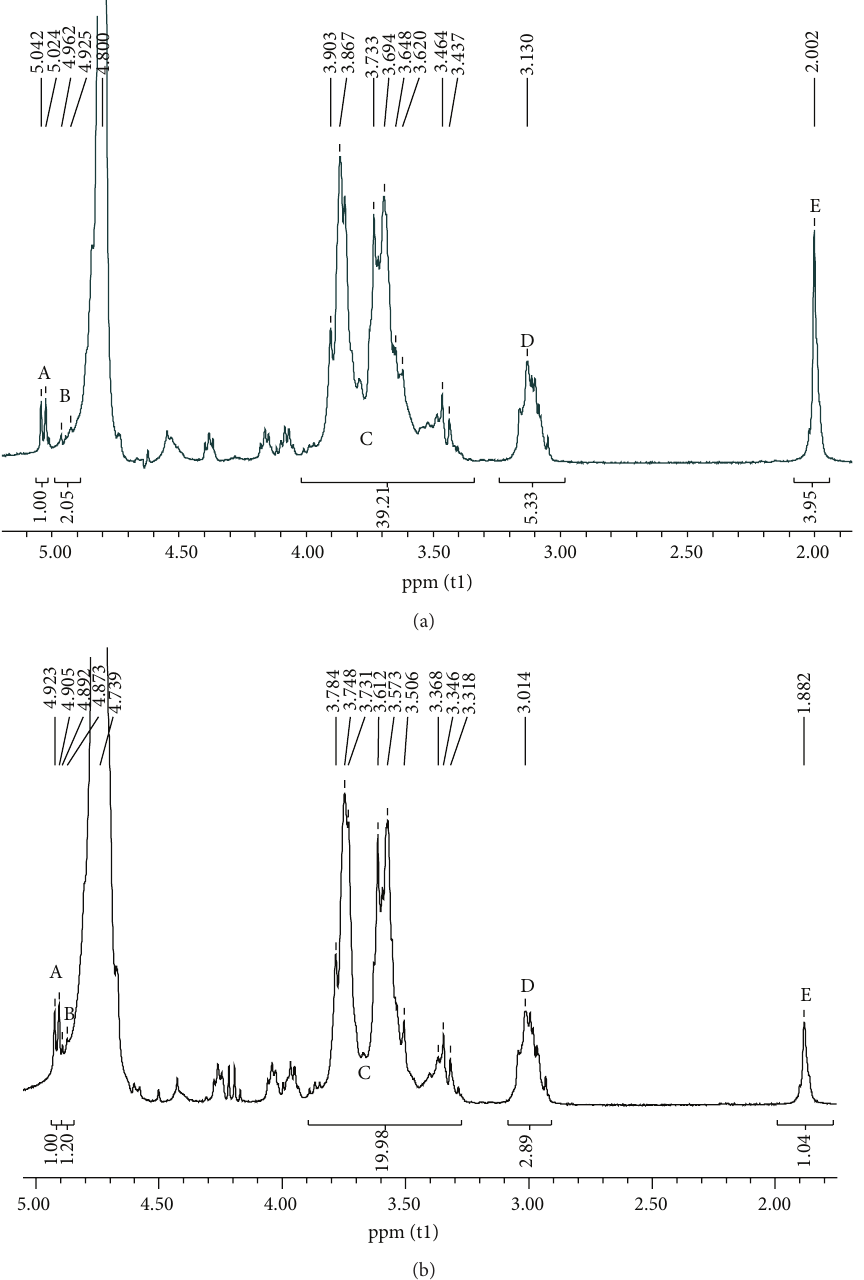
Figure 4: : 1 H NMR spectra of control chitosan sample A (a) and chitosan sample C (b), thermally treated at 100 ∘ C for 10h. 3 (0.33 mol dm −3 of acetic acid and 0.3 mol dm −3 of sodium chloride) as described by Roberts [8]. From the linear regres- sions of control chitosan (A) using solvents (1), (2), and (3) were calculated intrinsic viscosities and Mv values using the −1 , Mark-Houwink-Kuhn-Sakurada equation, 1,254,259 g mol 121,048 g mol −1 , and 193,400 g mol −1 , respectively. (For linear regressions, see Supplementary Figure